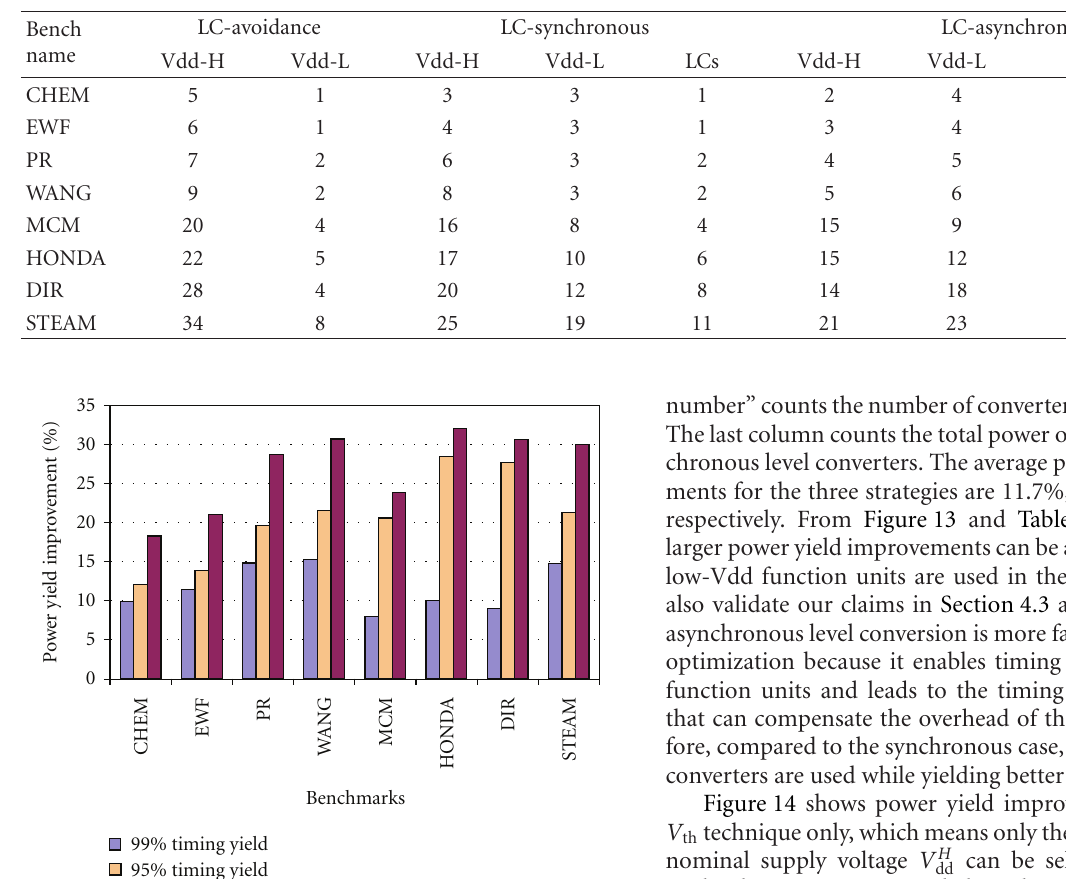
Table 3: The usage of function units and level converters with di ff erent level conversion strategies.